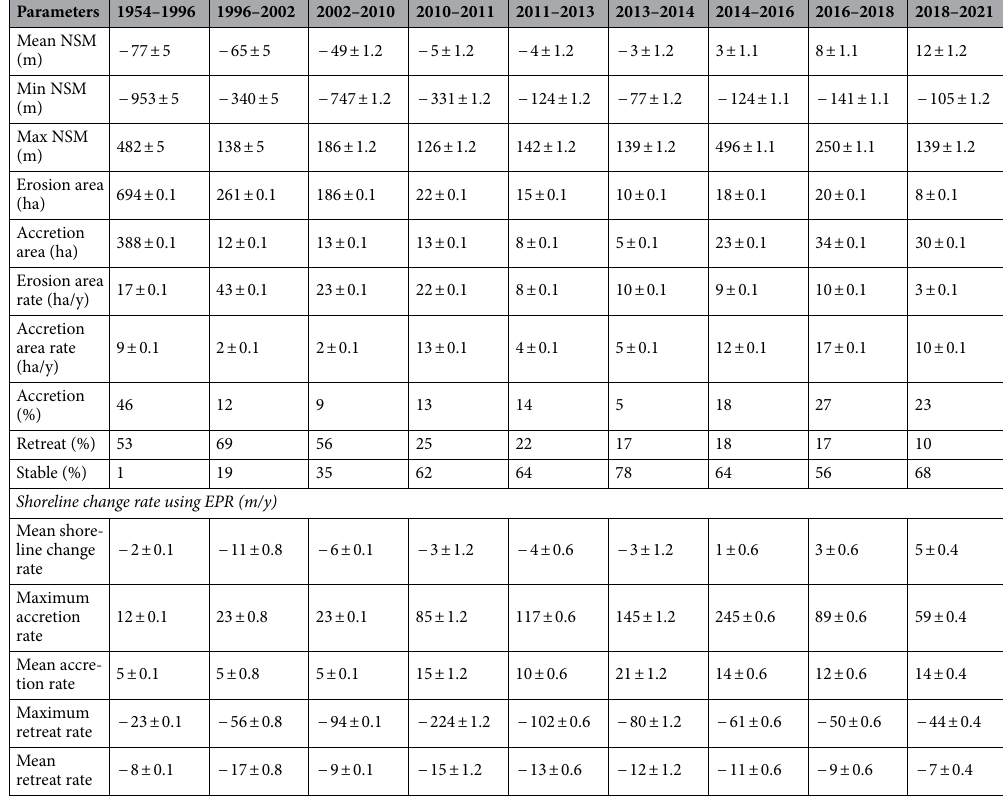
Table 1. Results of both long-term and short-term (interannual) shoreline change on the eastern Chao Phraya coast. NSM = net shoreline movement, EPR = end point